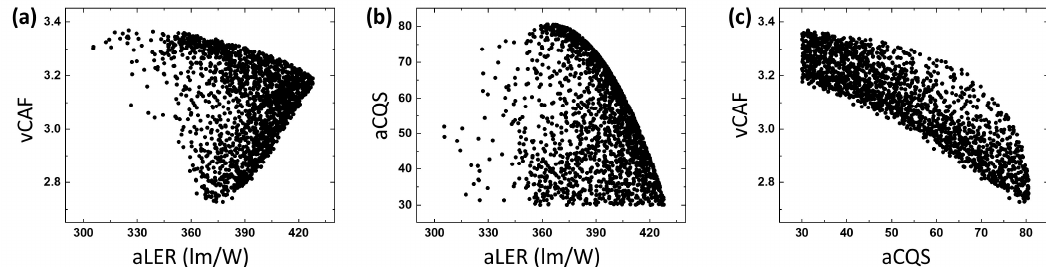
Figure 6. Pareto Fronts in three-view diagrams of optimized (a-c) RG P B-type SSL where CCT varies from 2700K to 6500K.